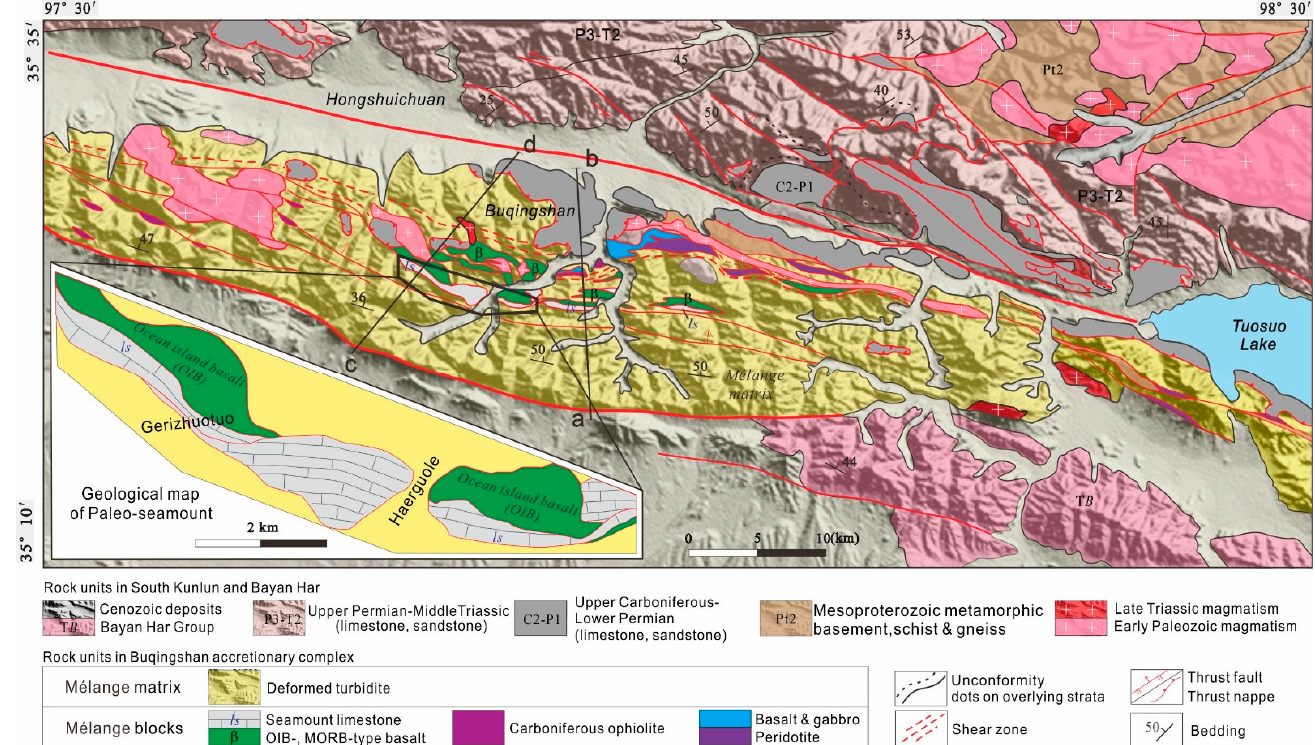
Figure 5. Geological map of the Buqingshan accretionary complex (see Figure 3 for location).